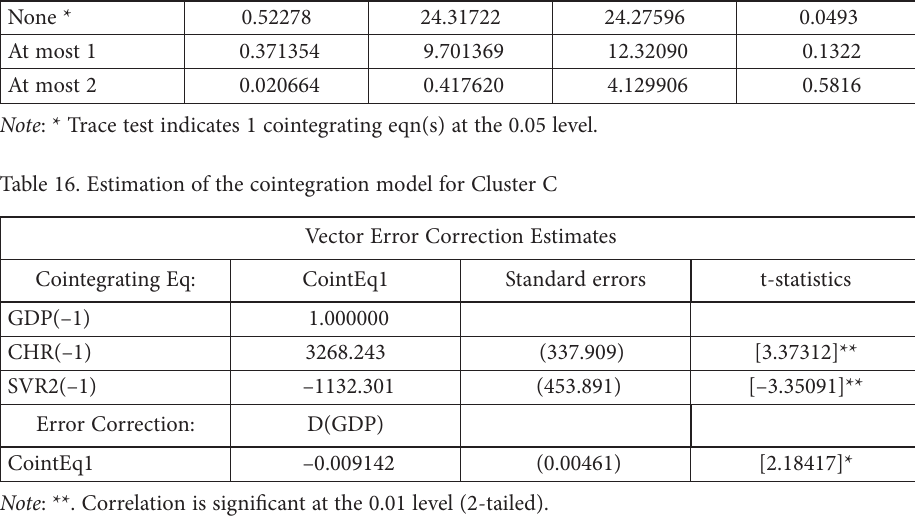
Table 15. Johansen Cointegration Test for Cluster C Series: GDP CHR SVR2 Lags interval (in first differences): 1 to 2 Unrestricted Cointegration Rank Test (Trace)